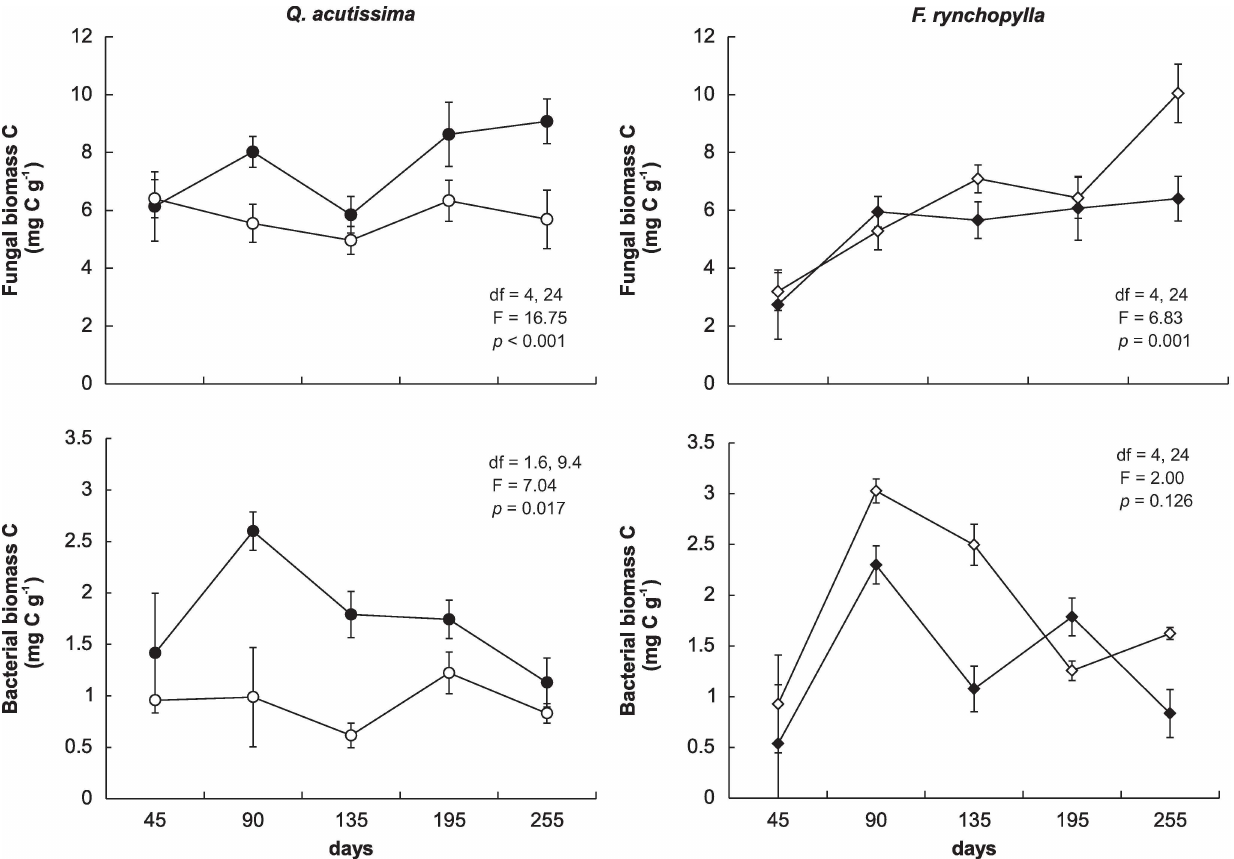
Fig 3. Changes in the fungal and bacterial biomasses in the decomposing leaf litter in the microcosms. Closedcircles represent leaf litter obtainedfrom the ambientair (380 ppm CO 2 ) chamber, and open circles representleaf litter obtainedfrom the elevated CO 2 (700 ppm) chamber. Bars show standard deviations (n =